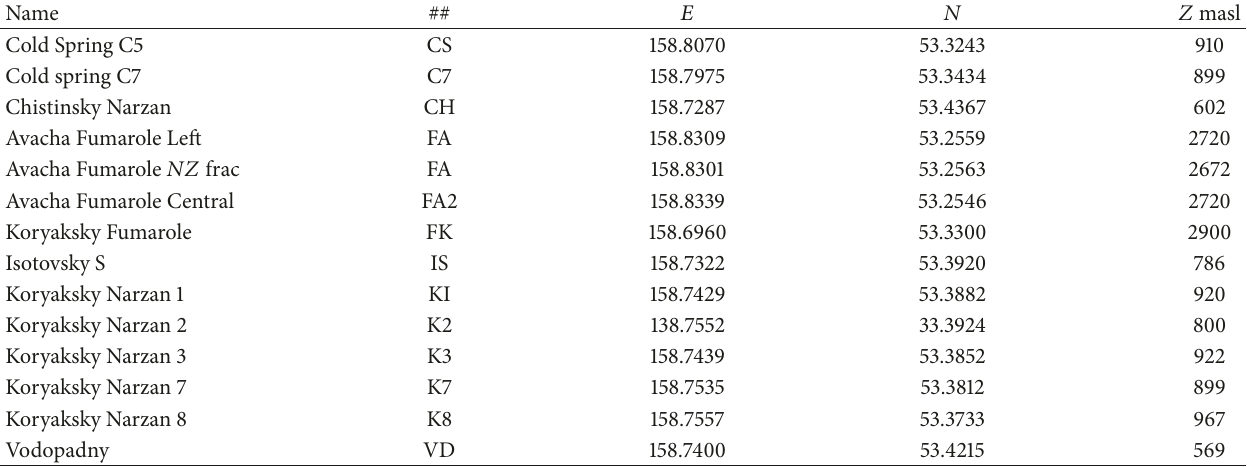
Table 1: Hot and cold springs of the Koryaksky-Avachinsky volcanogenic